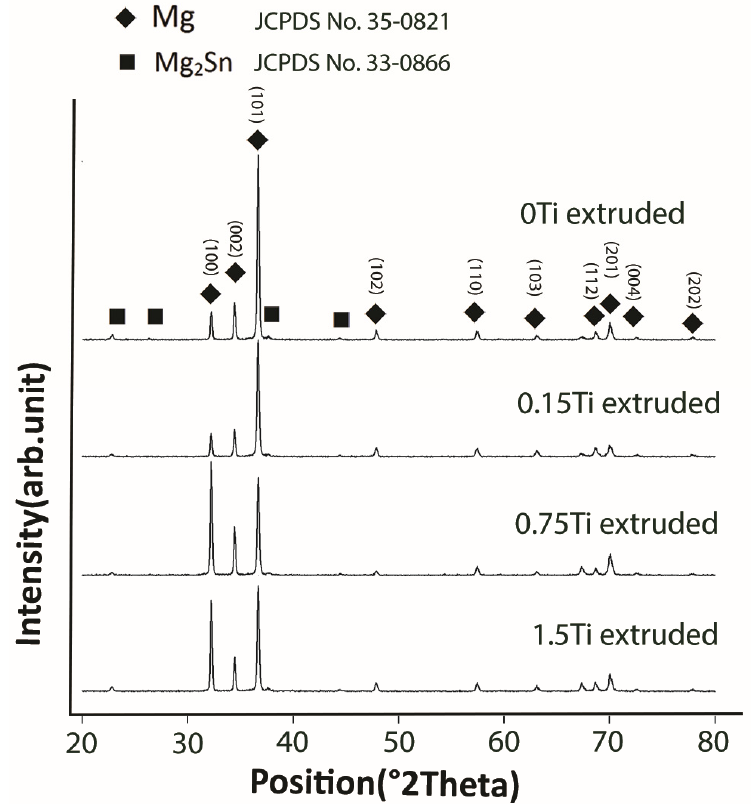
Figure 3. The XRD pattern of extruded Mg-5Sn-xTi samples.